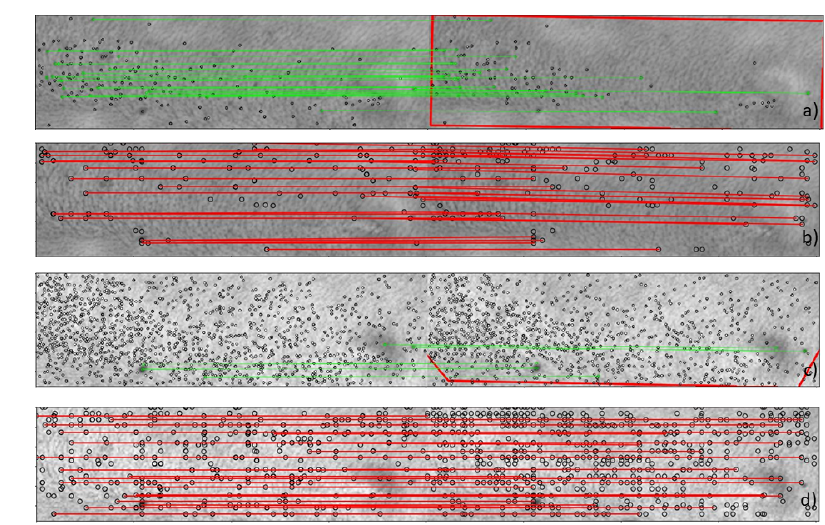
Figure 8. ( a ) Speed Up Robust Features (SURF) correspondences (green) after random sample consensus (RANSAC) geometric verification for subject no. 3 when principal components analysis (PCA) is used as a band extraction method. The two images correspond to the acquired images during inhalation and exhalation for the second principal component. ( b ) Deep local features (DELF) correspondences (red) after RANSAC geometric verification for subject no. 3 when PCA is used as a band extraction method. The two images correspond to the acquired images during inhalation and exhalation for the second principal component. ( c ) SURF correspondences after RANSAC geometric verification for subject no. 3 ( ≈ 590 nm) when the band selection algorithms Volume-Gradient-Based Band Selection (VGBS) and SSBS are used. ( d ) DELF correspondences after RANSAC geometric verification for subject no. 3 ( ≈ 590 nm) when the band selection algorithms VGBS and SSBS are